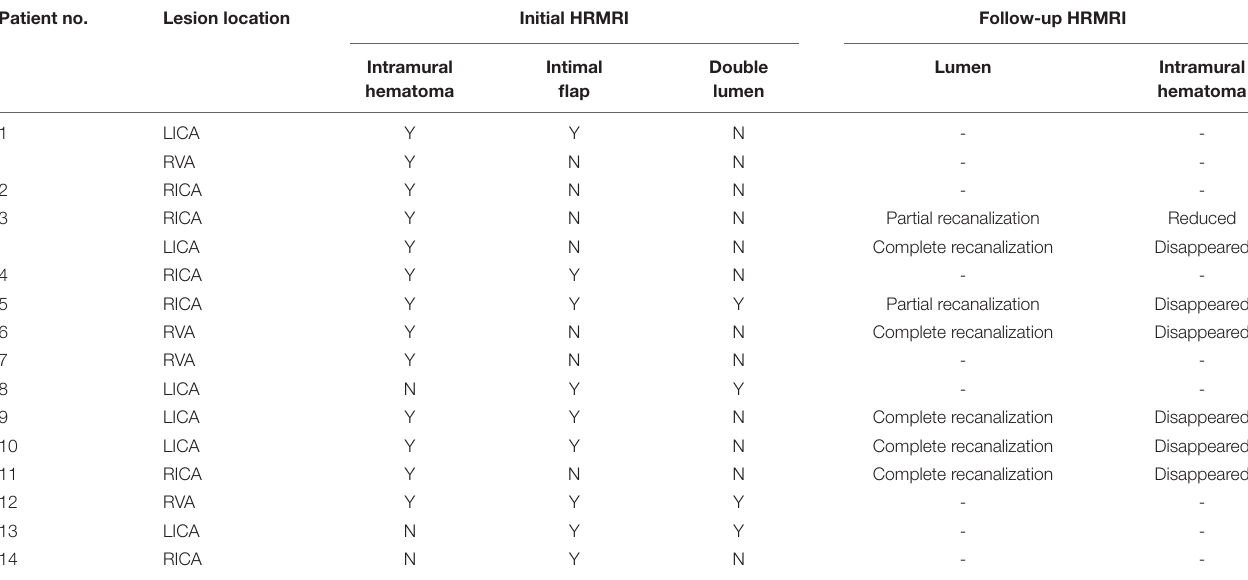
LICA, left internal carotid artery; RICA, right internal carotid artery; RVA, right vertebral artery; Y, yes; N, no; HRMRI, high-resolution magnetic resonance imaging.